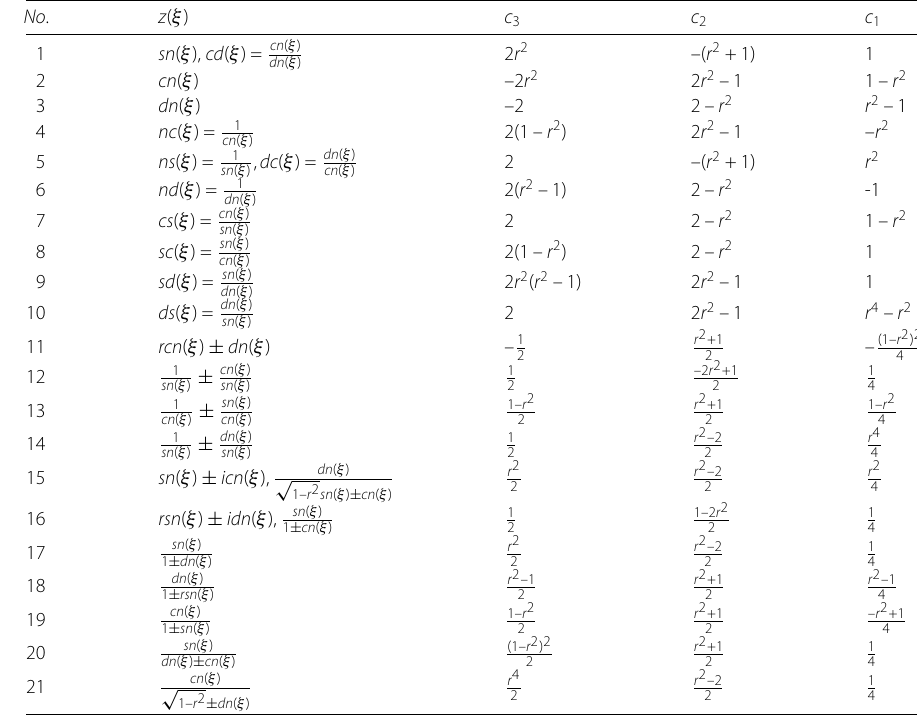
Table 1 Different solutions of the